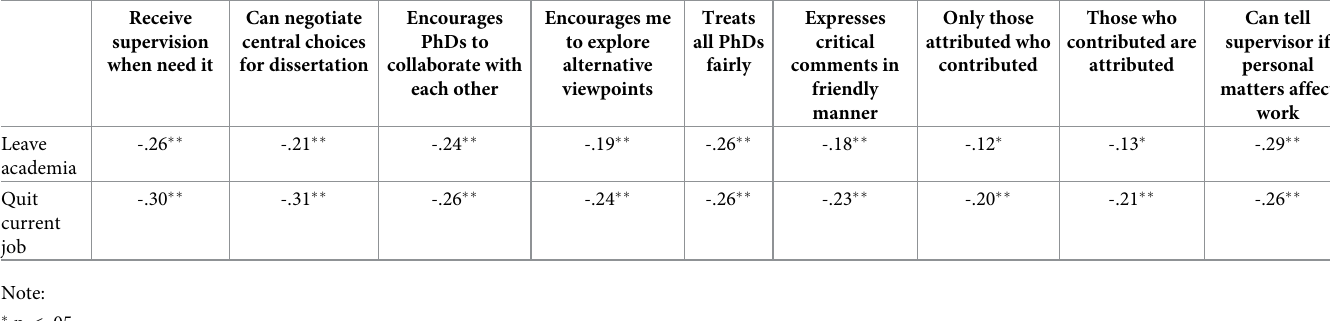
Table 7. Spearman correlations for supervision items and leave/quit considerations (negative correlation).